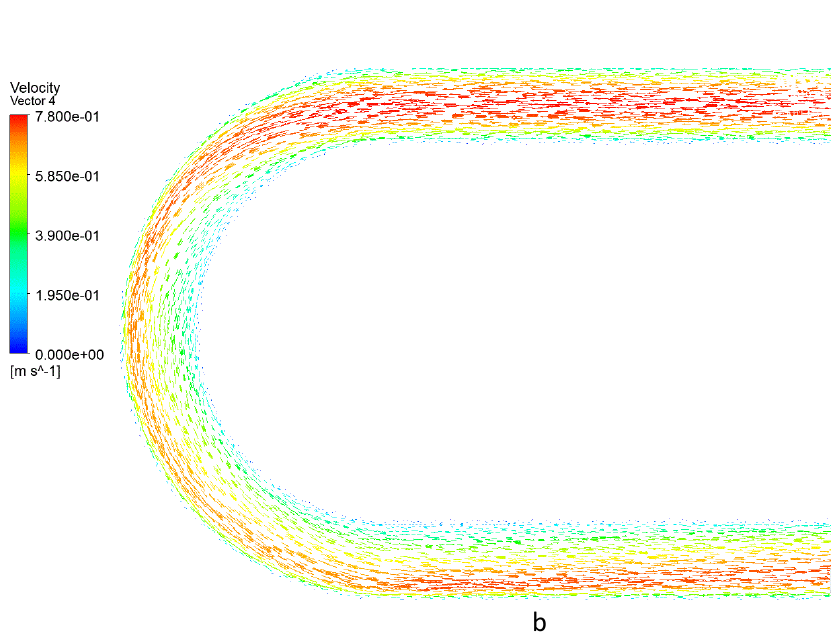
Figure 12. Velocity magnitude contour distribution across the plane locations ( a ) and velocity vectors along the curvature section ( b ) using fruit